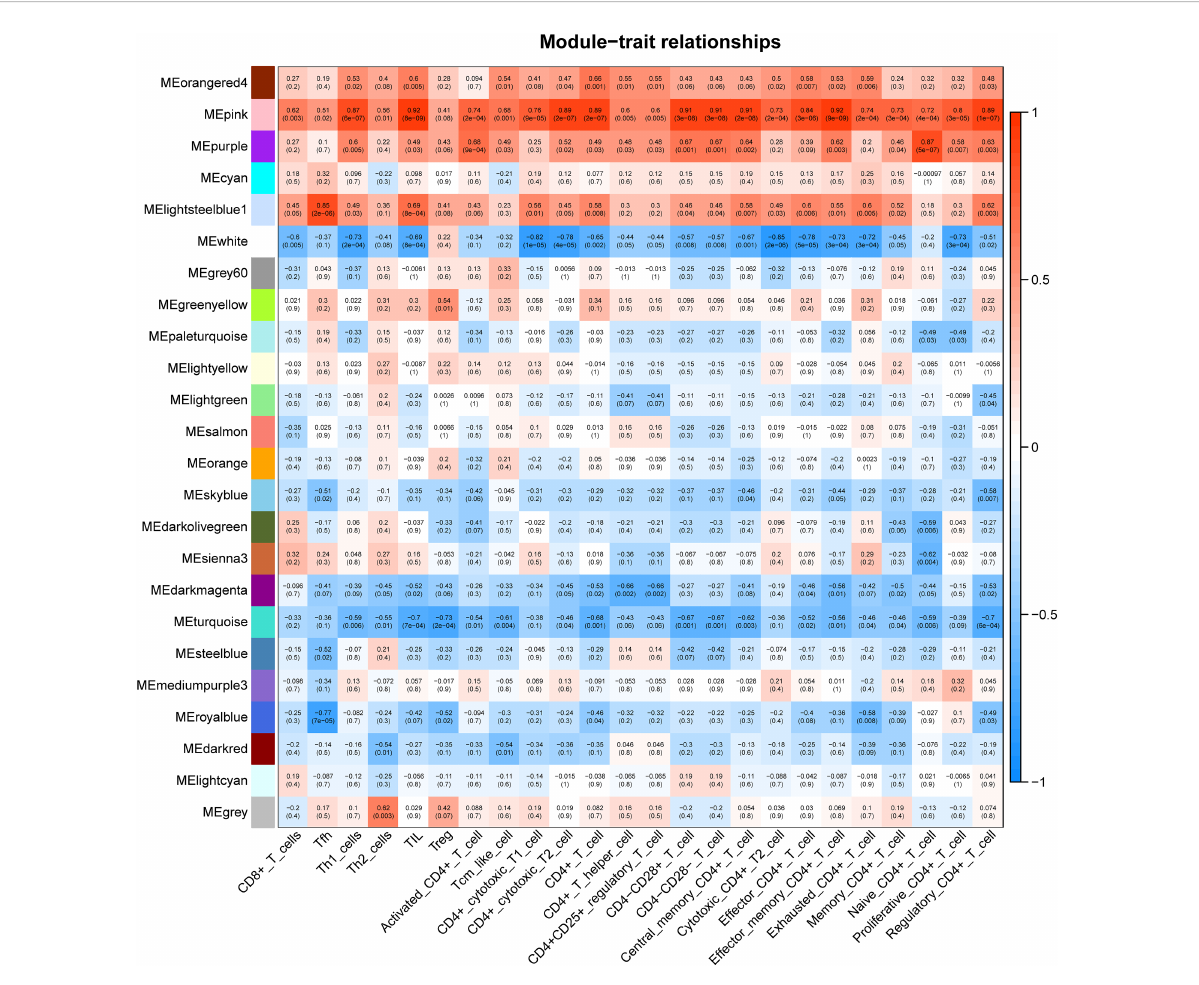
FIGURE 5 Correlation between diverse subtypes of immune-in fi ltrating T cells and different gene